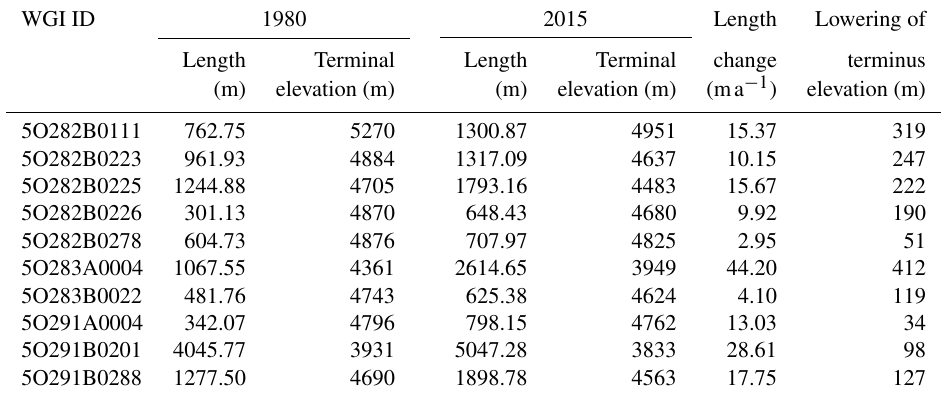
Table 5. Length change of advancing glaciers in the Kangri Karpo. The uncertainties in glacier length in 1980 and 2015 are 6 and 7.5m, and the uncertainty of length change is 0.27ma − 1 .